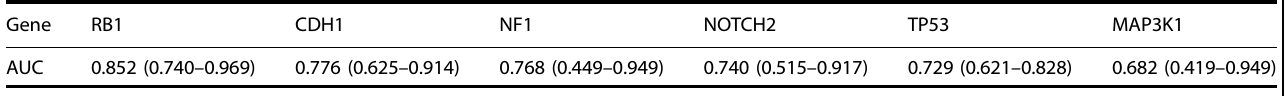
The top 6 results are reported out of 18 genes.